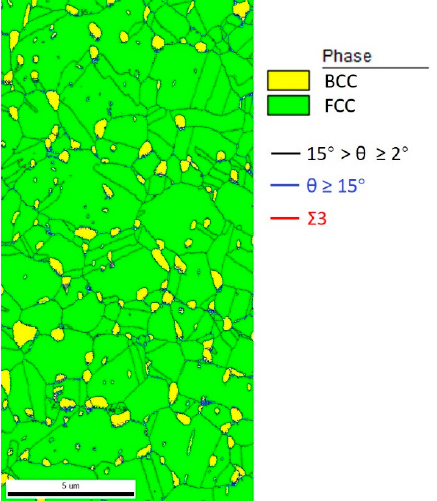
Figure 2. Grain boundary map superimposed with phase map of the dual-phase ultrafine-grained (UFG) Fe-20Mn-8Al-5Ni-0.8C alloy, observed by SEM-EBSD. Low-angle grain boundaries (15° > θ ≥ 2°), high-angle grain boundaries ( θ ≥ 15°), and twin boundaries ( Σ 3) are respectively indicated by black, blue, and red lines. The grain and yellow background represent austenite phase and B2 phase, respectively. The B2 phase in the material was indexed as BCC ( α ) phase by EBSD because they have quite similar Kikuchi patterns.